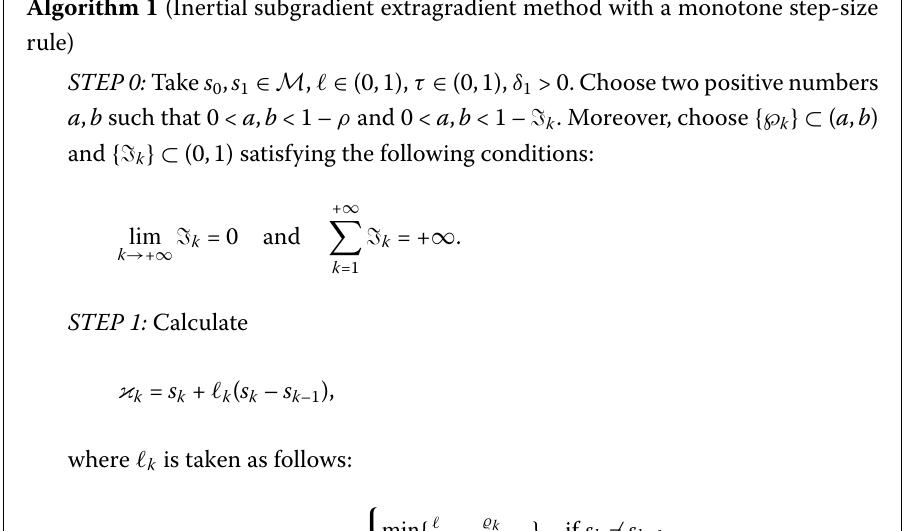
Algorithm 1 (Inertial subgradient extragradient method with a monotone